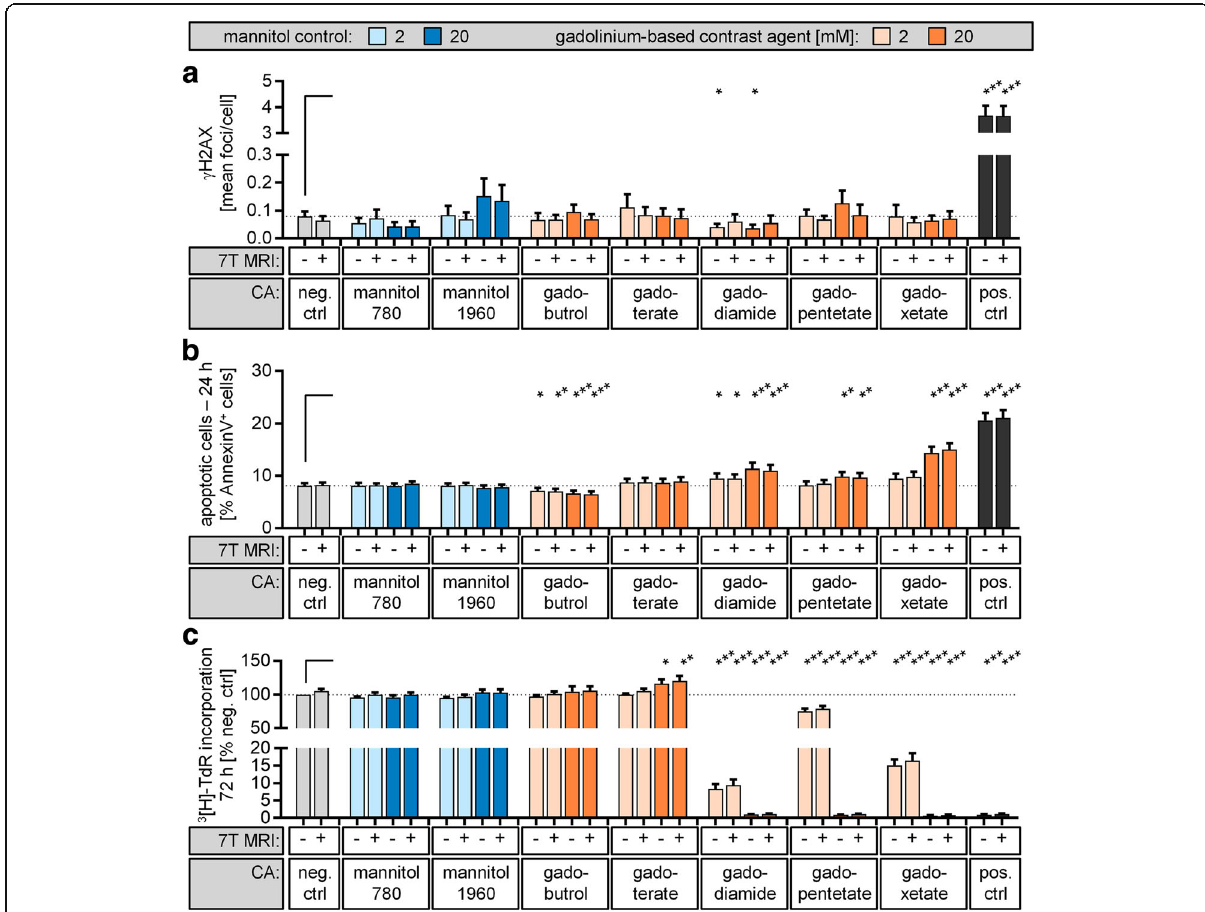
Fig. 2 Genotoxic and cytotoxic impact of contrast-enhanced 7-T MRI exposure. Isolated lymphocytes were incubated with the indicated class and concentration of gadolinium-based contrast agent. Samples incubated in cell culture medium only ( neg. ctrl ) or with mannitol solution comparable with the lowest (780 mOsm/kg H 2 O; gadodiamide) and highest (1960 mOsm/kg H 2 O; gadopentetate dimeglumine) osmolality of GBCAs served as controls. Additionally, samples were either exposed to 7-T MRI ( + ) or placed outside the MRI scanner (-) at the same temperature. a The level of DNA double-strand breaks was assessed 15 min after exposure by γ H2AX staining and automated foci quantification. Lymphocytes irradiated with 0.5 Gy served as positive controls ( pos. ctrl ). b Apoptosis rate was quantified after 24 h by Annexin V/propidium iodide staining combined with flow cytometric analysis. Samples treated with 2 μ M camptothecin served as positive controls. c For proliferation analysis, lymphocytes were activated with PHA directly after MRI exposure. Level of DNA synthesis was determined after 72 h by [ 3 H]-thymidine incorporation. Lymphocytes treated with 2 μ M camptothecin served as positive controls. Diagrams display mean ± standard error of the mean of 12 experiments (*** p ≤ 0.001; ** p ≤ 0.01; * p ≤ 0.05) and raw data are listed in Additional file 1: Tables S4 –